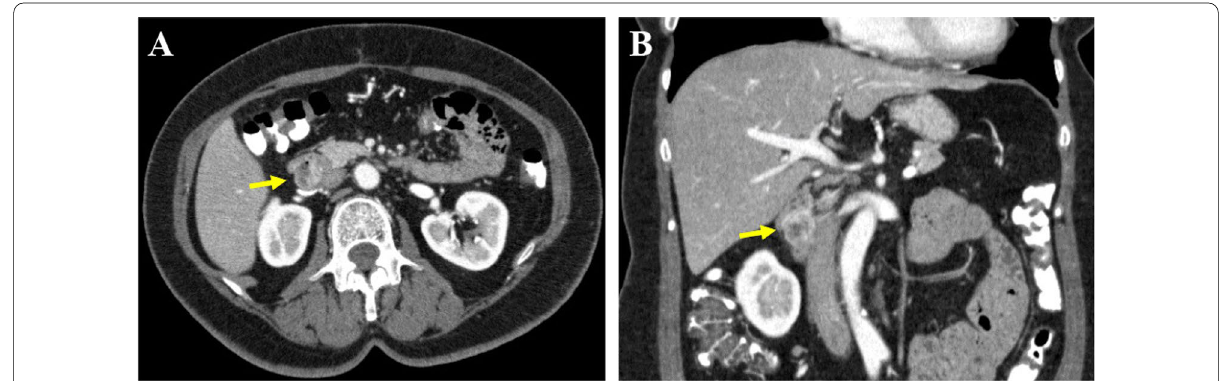
Fig. 1 A , B Contrast-enhanced computed tomography at the first visit. Extravasation was seen from a 20-mm mass in the second part of the duodenum